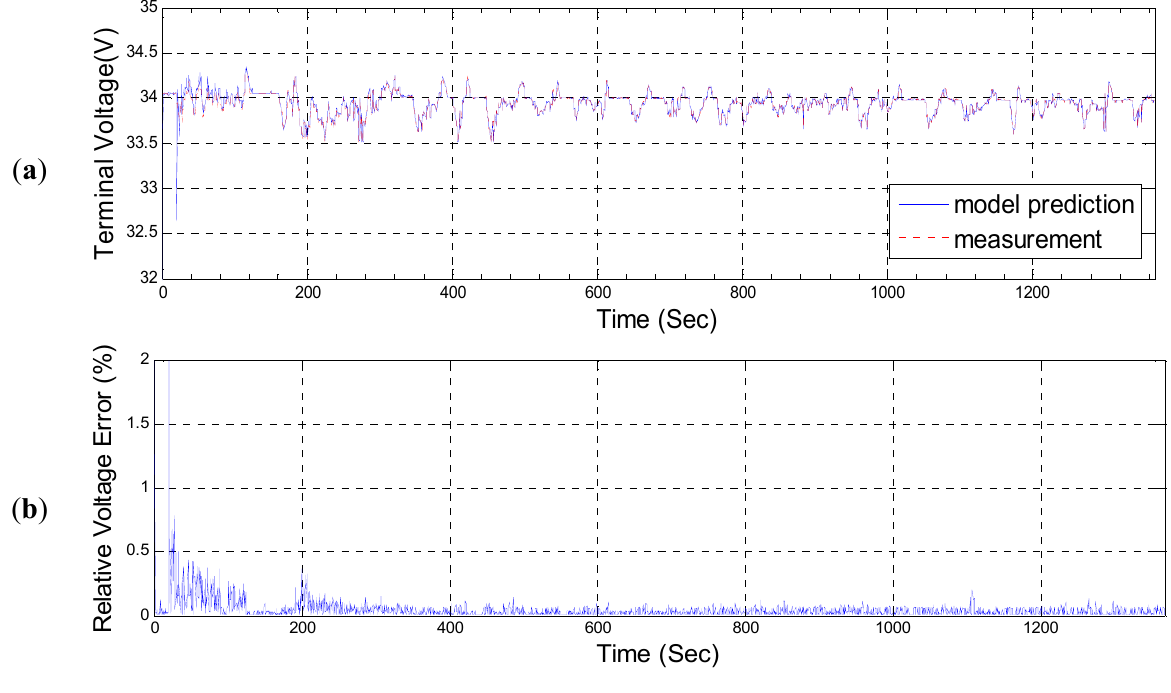
Figure 9. Validation results of the voltage responses in a FUDS cycle: ( a ) Measured and predicted battery voltage responses; ( b ) Relative error rate.